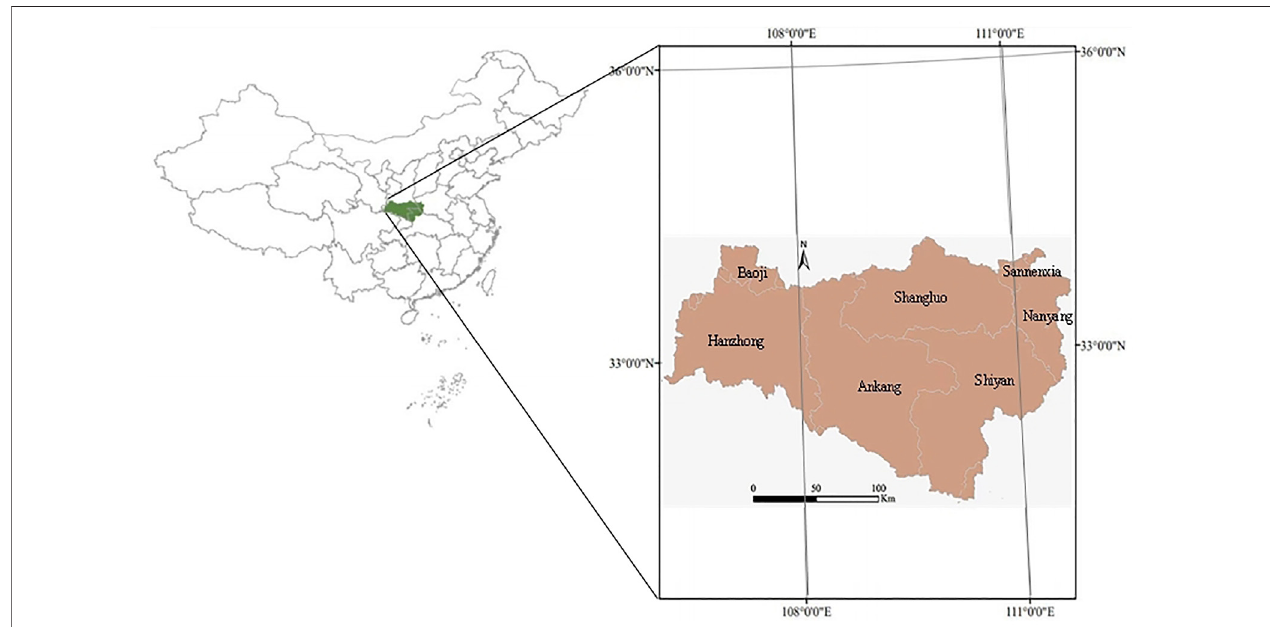
FIGURE 1 | Water source district administrative zoning map. Note: The map was generated by ArcGIS 10.5. URL link: https://www.esri.com/en-us/arcgis/ products/districting-for-arcgis/overview.